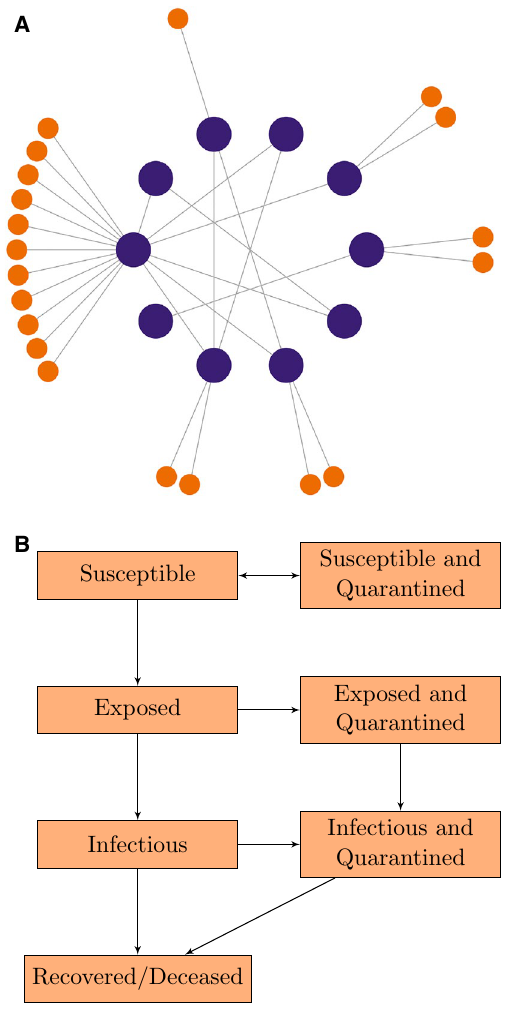
Figure 1. ( A ) Example of a contact network representing members of the institution (large, purple nodes) and their contacts in the periphery (small, orange nodes). Here we have 10 institution members who make an average of 2 contacts within the institution and 2 contacts outside the institution ( variance = 3 for both distributions). ( B ) Flowchart of compartments and possible state